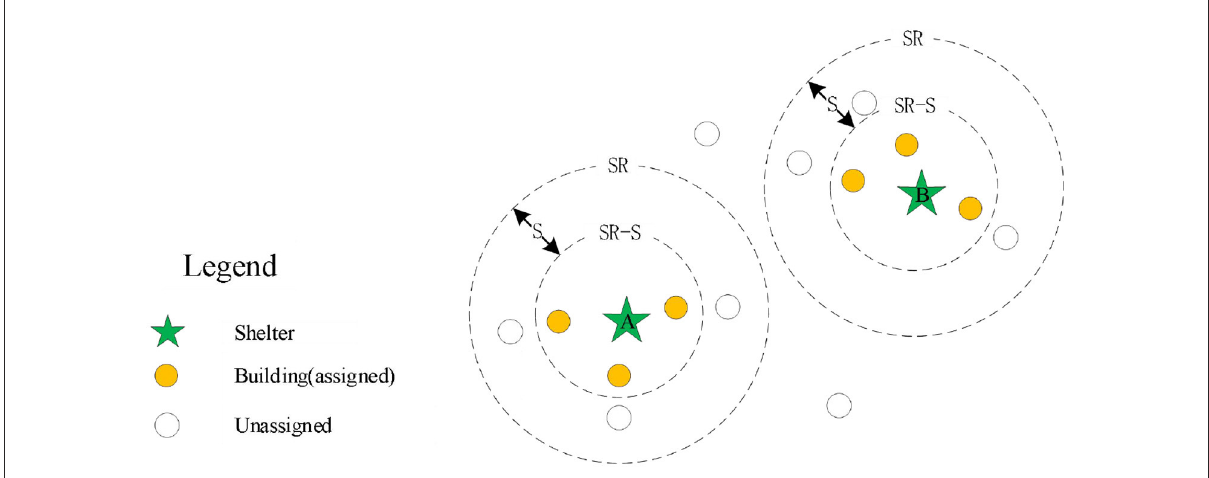
FIGURE3 The scenario analysis of without intersecting area.